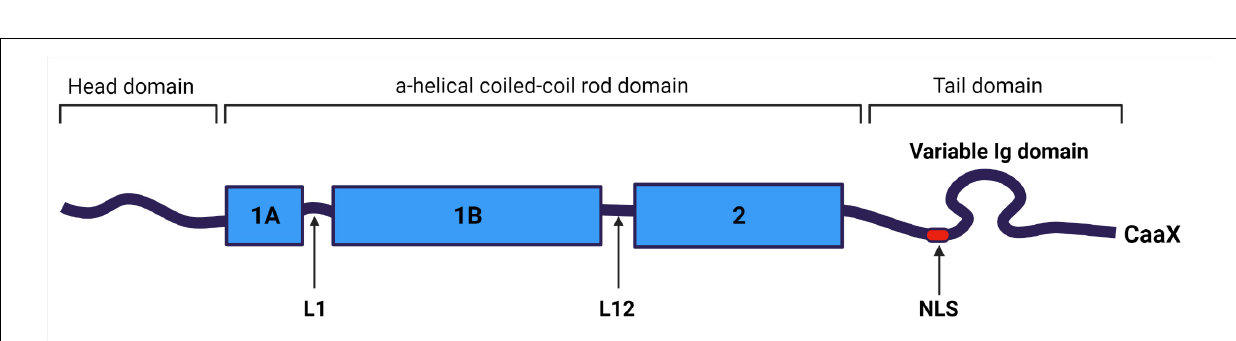
Frontiers in Cell and Developmental Biology |